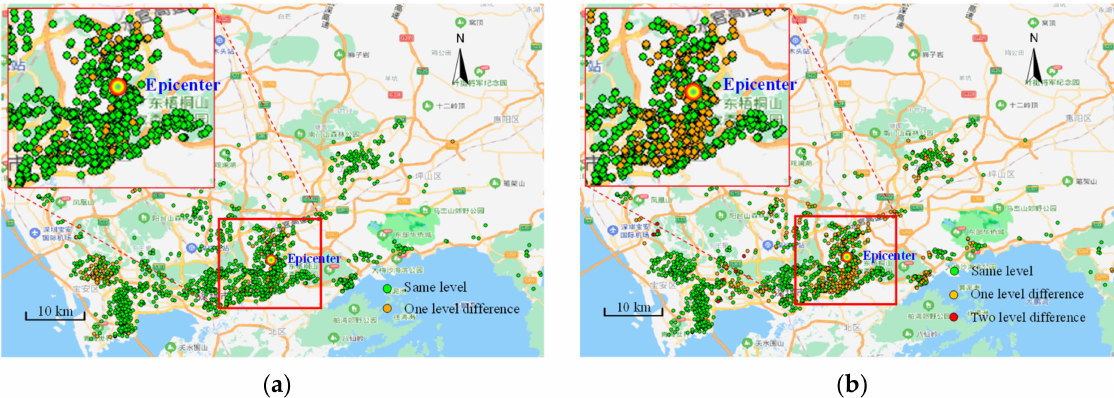
Figure 20. Prediction error of the MI-CNN model: ( a ) M6.5 earthquake scenario; ( b ) M7.5 earthquake